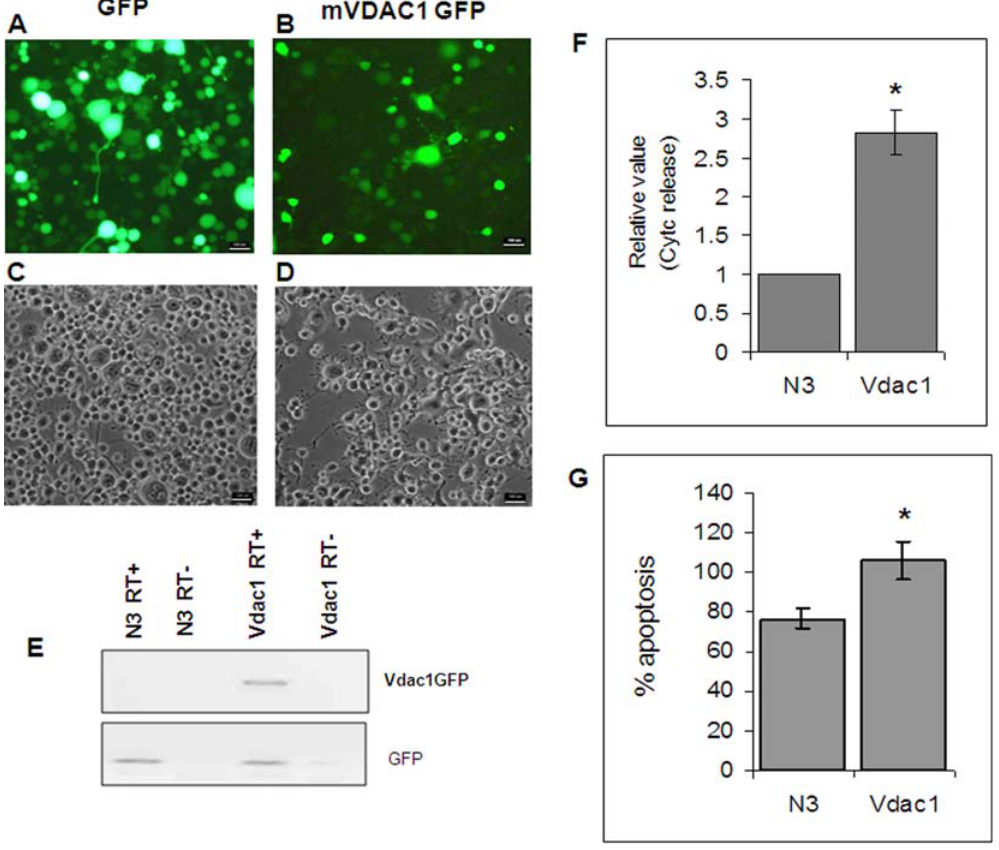
Figure 8. Over-expression of murine Vdac1 (mVdac1) in Neuro-2a cells induces apoptosis. (A–D) Neuro-2a cells transfected with pEGFPN3 vector alone (N3)(A& C) and mVdac1GFP(B& D)[A& B, Fluorescentfield; C & D,Brightfield view under10 6 objective inanepifluorescencemicroscope(Nikon)]. (Scale bar,100 um). (E) Expression of mVdac1Gfp in Neuro-2a cells was confirmed by Reverse transcription followed by PCR (RT-PCR) amplification from cDNA using a Vdac1 specific forward primer and GFP specific reverse primer (Upper panel). Expression of GFP was checked in N3 and mVdac1GFP transfected cells by RT-PCR using GFP specific forward and reverse primers. RT + : with reverse transcriptase, RT-: without reverse transcriptase. (F) Release of cytochrome c into cytosol in mVdac1 transfected cells was determined by using a solid phase ELISA method 65H after transfection. Data is presented relative to vector transfected control (N3). Data represents mean 6 SEM of two independent experiments each in replicate. (*, p , 0.01, Student’s t-test) (G) Flow cytometric analysis of apoptosis in mVdac1GFP and N3 transfected cells (65H after transfection) was determined by counting annexinV-PE positive cells. Data represents mean 6 SEM of two independent experiments, each in replicate. (*, p , 0.05, Student’s t-test).